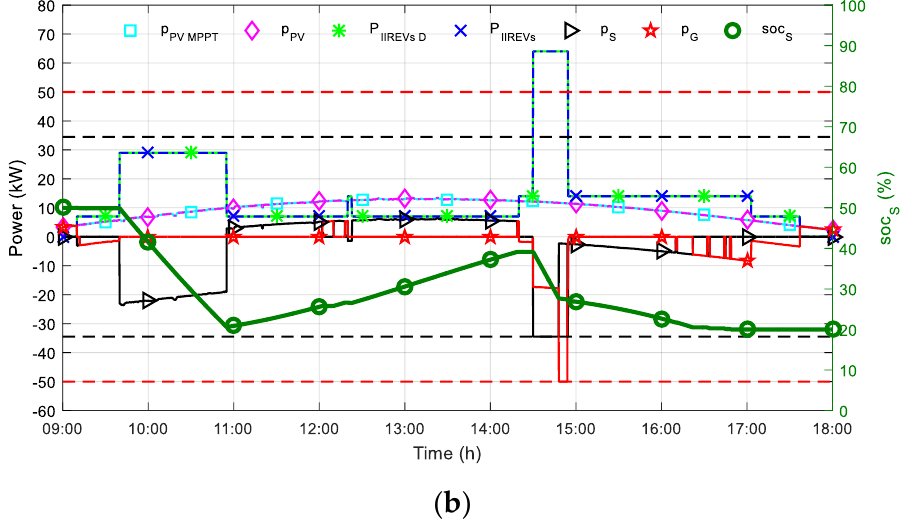
Figure 10. Power flow and storage state of charge in ( a ) “Sim w/o opt” and ( b ) “Sim with opt”— case 2.